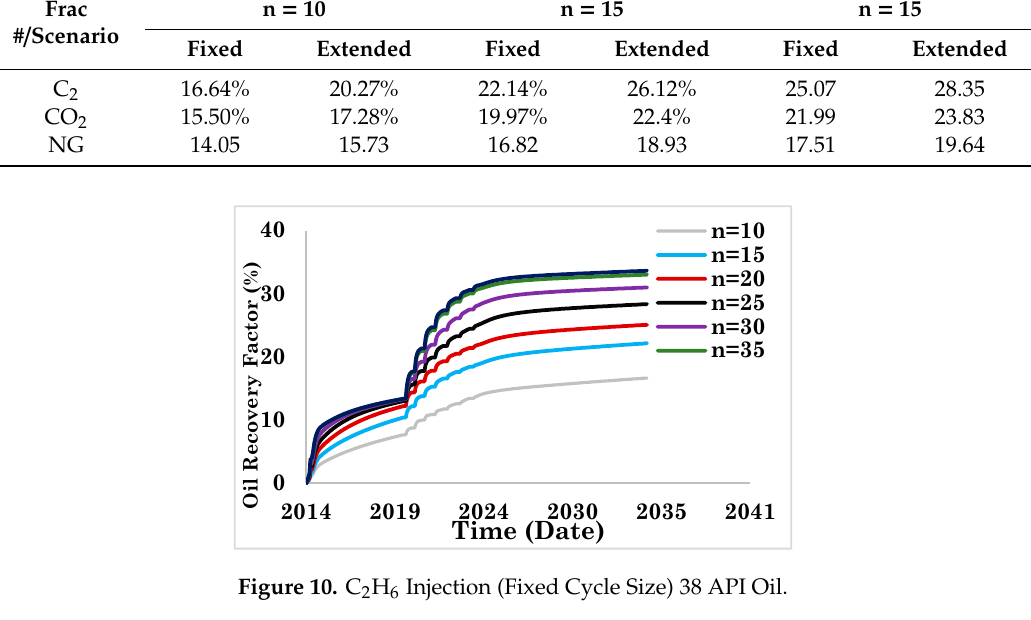
ff erent fracture stages